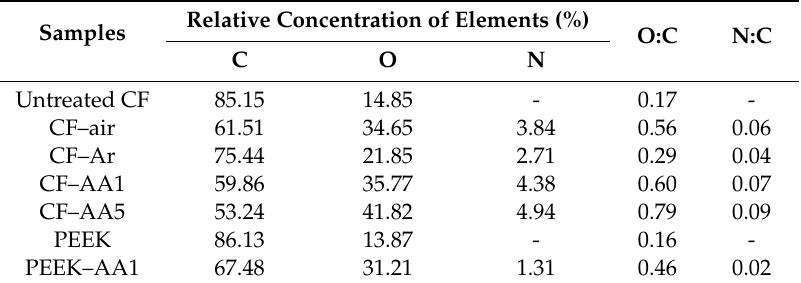
Table 4. Surface chemical composition of CFs and PEEK